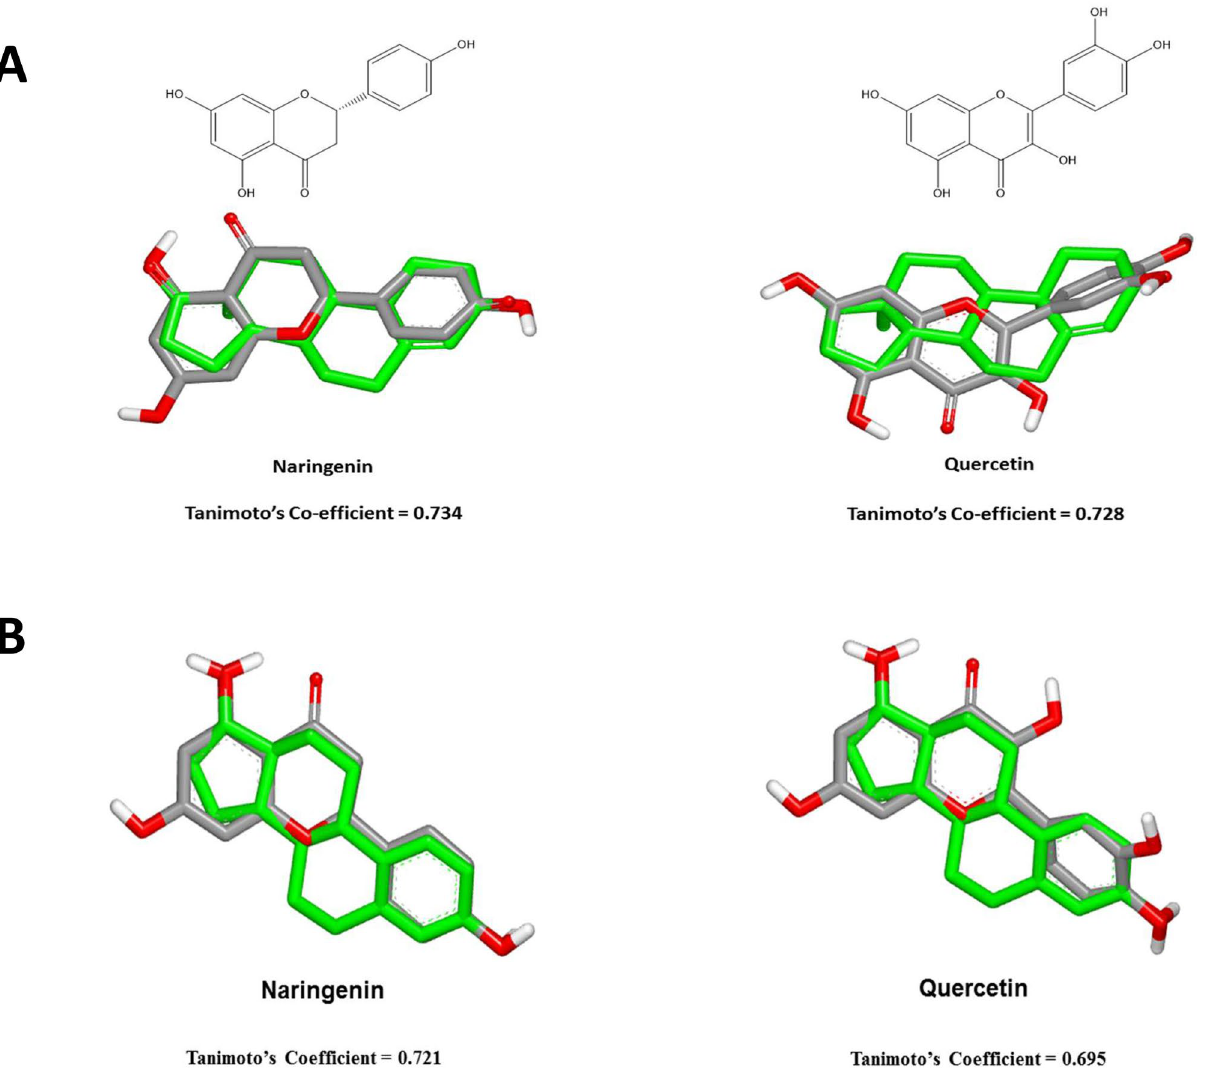
Figure 1. Superimposition of naringenin and quercetin in correlation to ( A ) androsterone and ( B ) 17-beta estradiol, showing Tanimoto